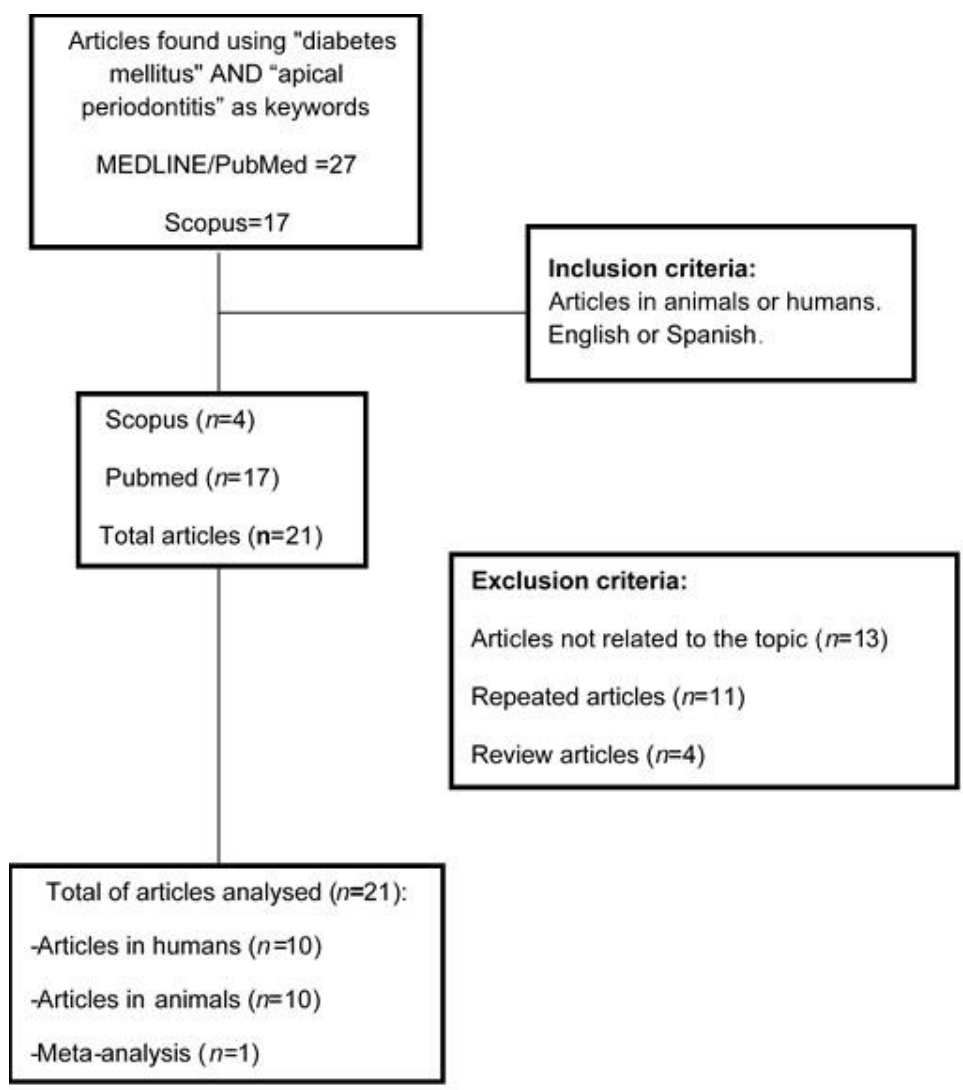
Figure 1. Flow diagram of selected articles.